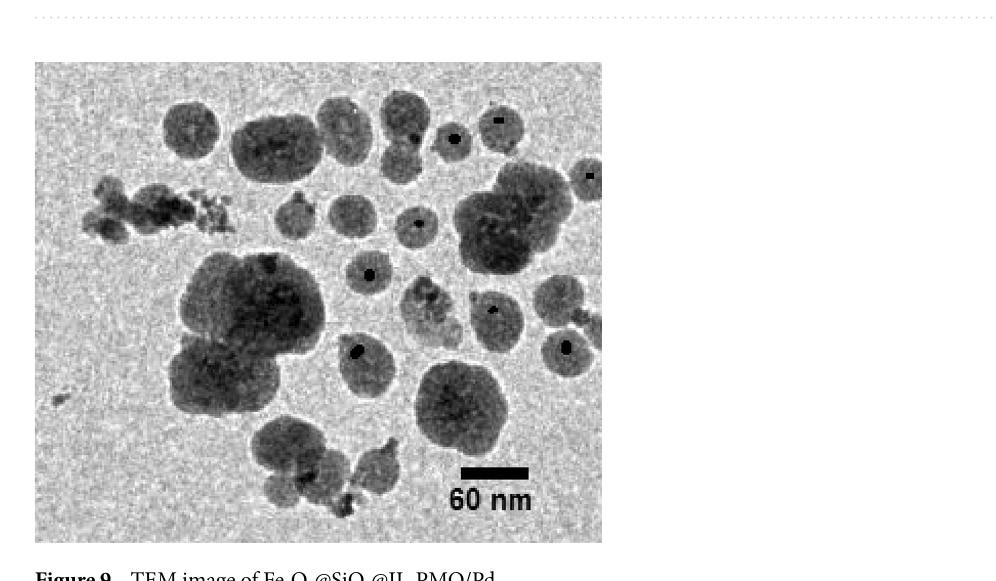
Figure 8. SEM image of ( a ) Fe 3 O 4 , ( b ) Fe 3 O 4 @SiO 2 , ( c ) Fe 3 O 4 @SiO 2 @IL-PMO and ( d ) Fe 3 O 4 @SiO 2 @IL-PMO/ Pd materials.